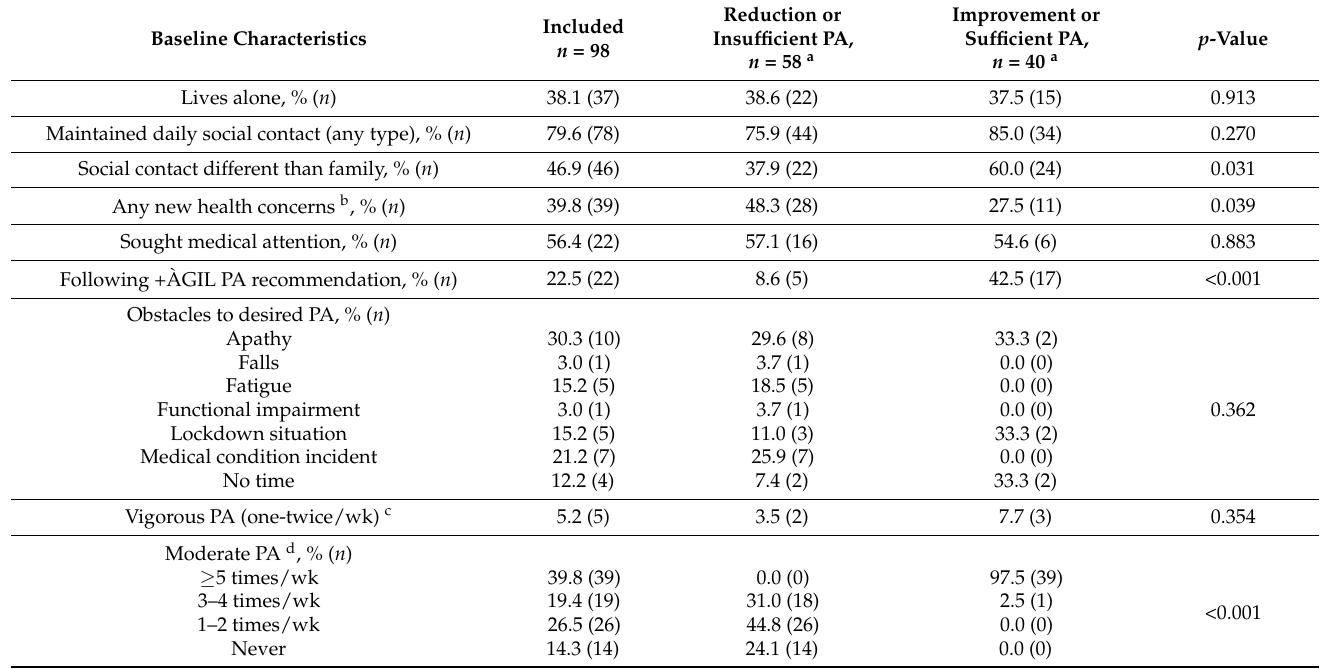
Table 2. Description of characteristics of the sample during the lockdown due to